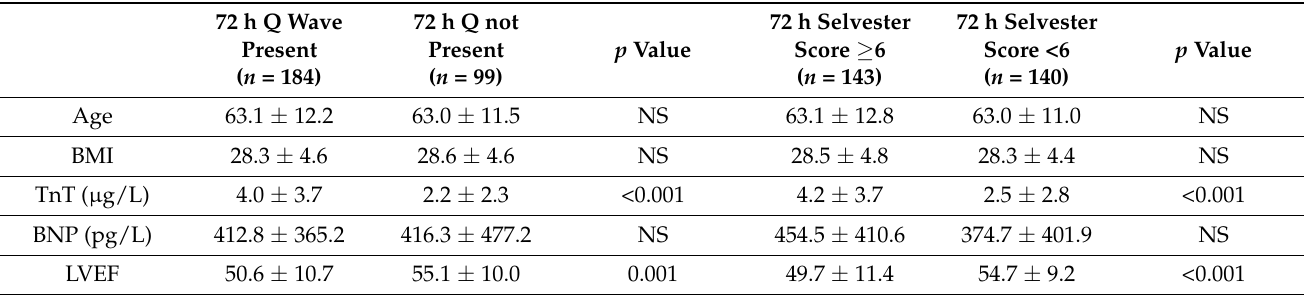
Table 2. Comparison of clinical characteristics of patients with and without Q wave and with 72 h Selvester score values of ≥ 6 and